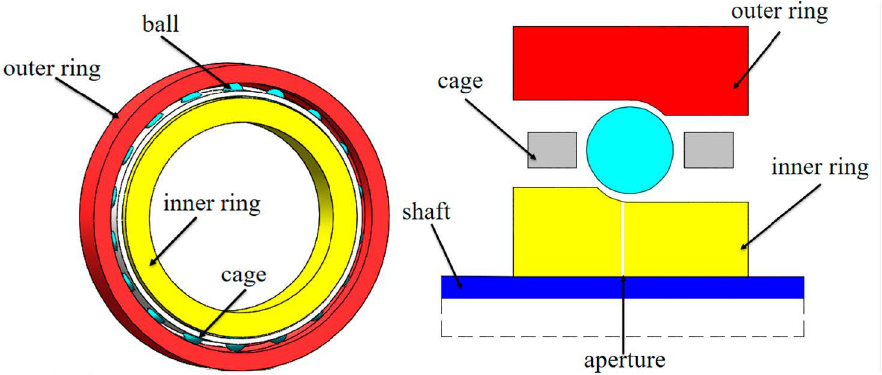
Figure 1. Configuration of ball bearing with under-race lubrication. Table 1. Geometry parameters of ball bearing.